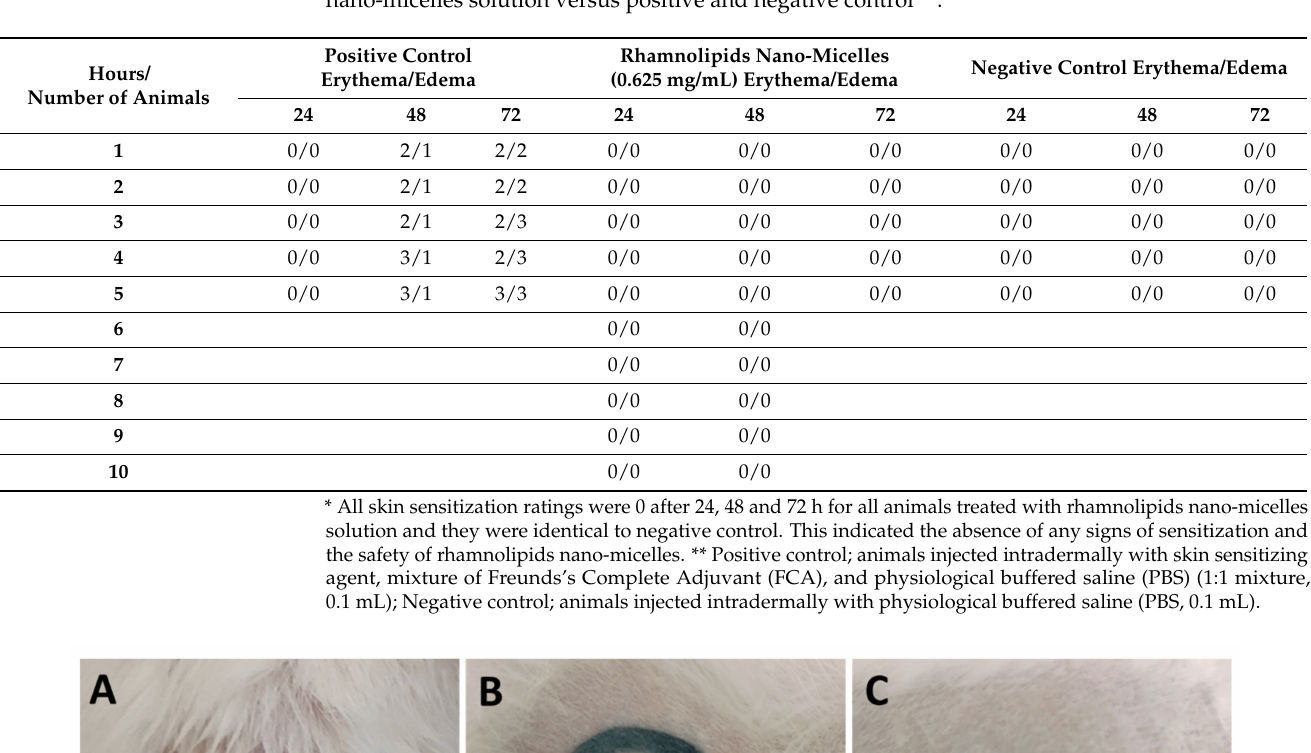
Table 3. * Skin sensitization scores recorded for guinea pigs injected intradermally with rhamnolipids nano-micelles solution versus positive and negative control **.